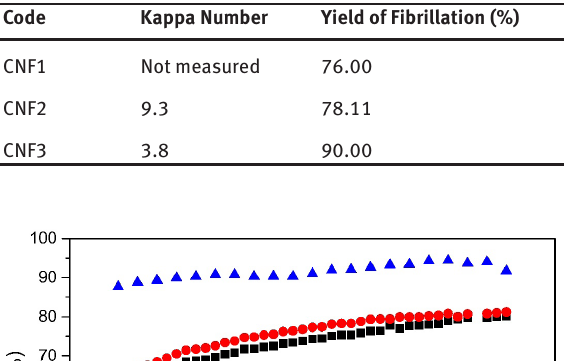
Table 2: Characteristic of CNF from LEFB. Code